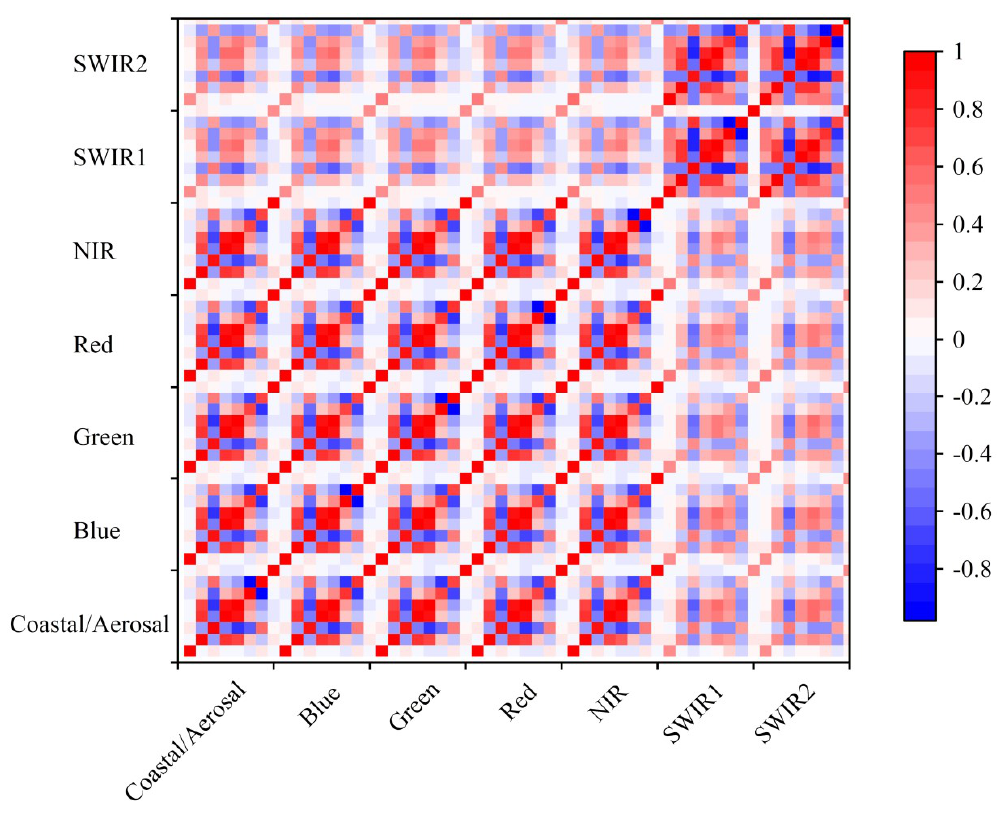
Figure 3. Detailed texture features combined with the correlation coefficient matrix of the spectral index.